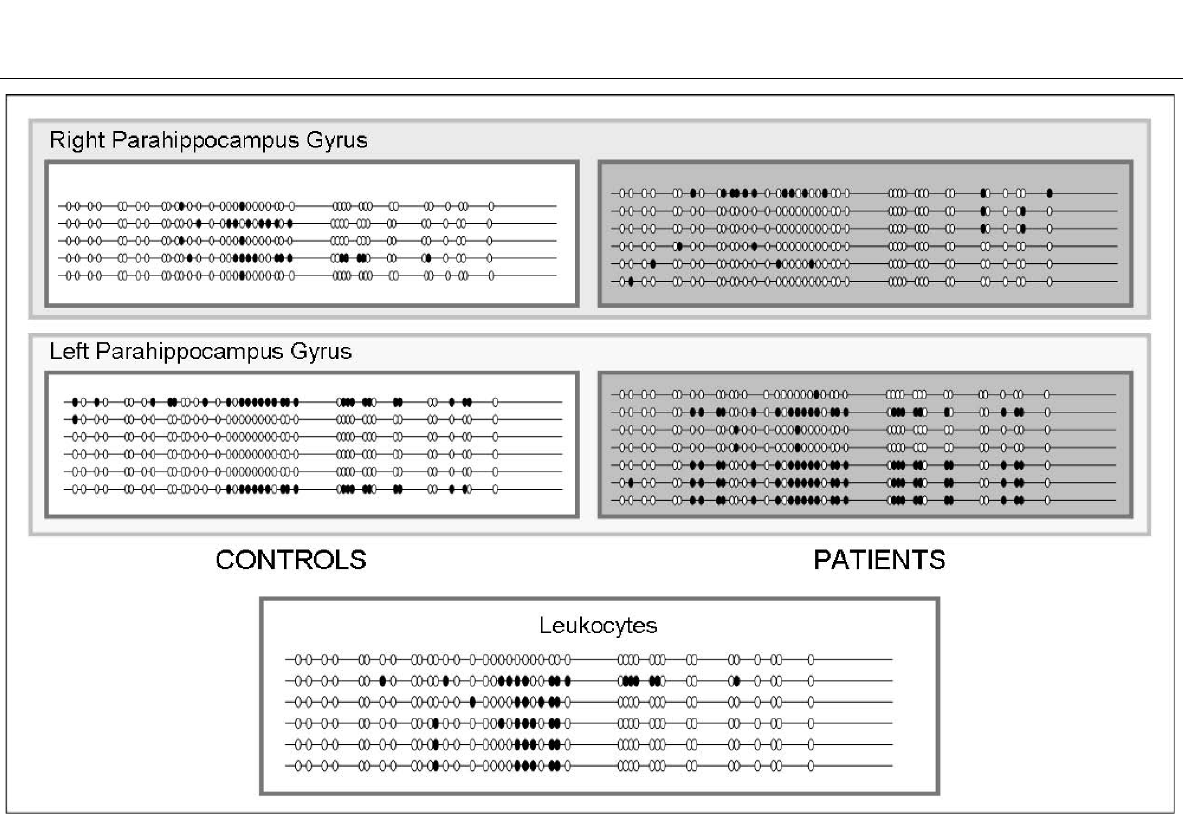
Figure 3 Bisulfite results for parahippocampus gyrus . Methylation data are represented as filled circles (methylated CpG) and empty circles (unmethylated CpG) for each bacterial clone obtained. Each row of circles represents the methylation pattern based on the sequence of one cloned PCR